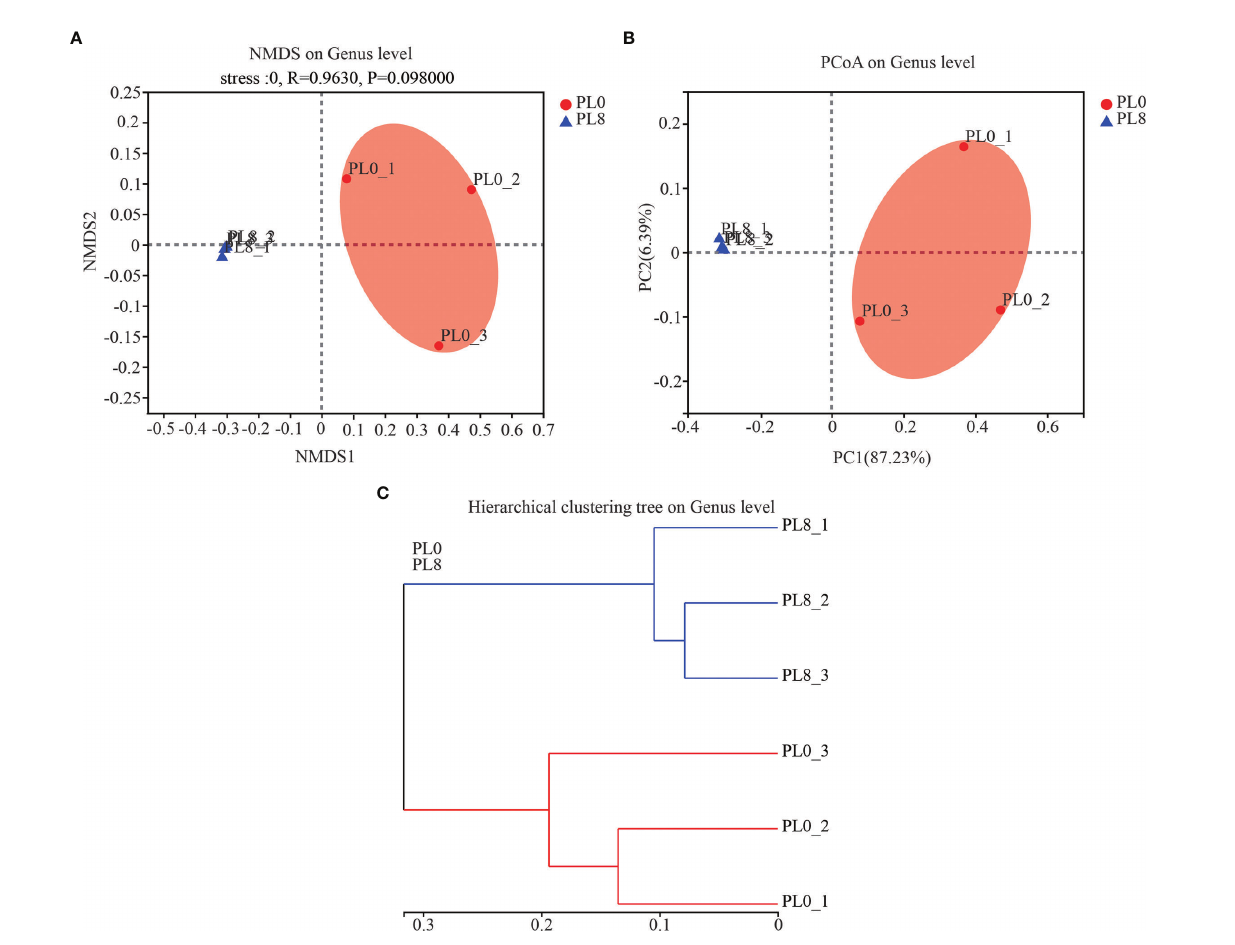
FIGURE 7 | The beta diversity comparisons analysis, including non-metric multidimensional scaling (NMDS) (A) , principal component analysis (PCoA) (B) , and hierarchical clustering tree analysis (C) of microbial communities at genus level in the intestine of largemouth bass fed the diets in the PL0 (control) and PL8